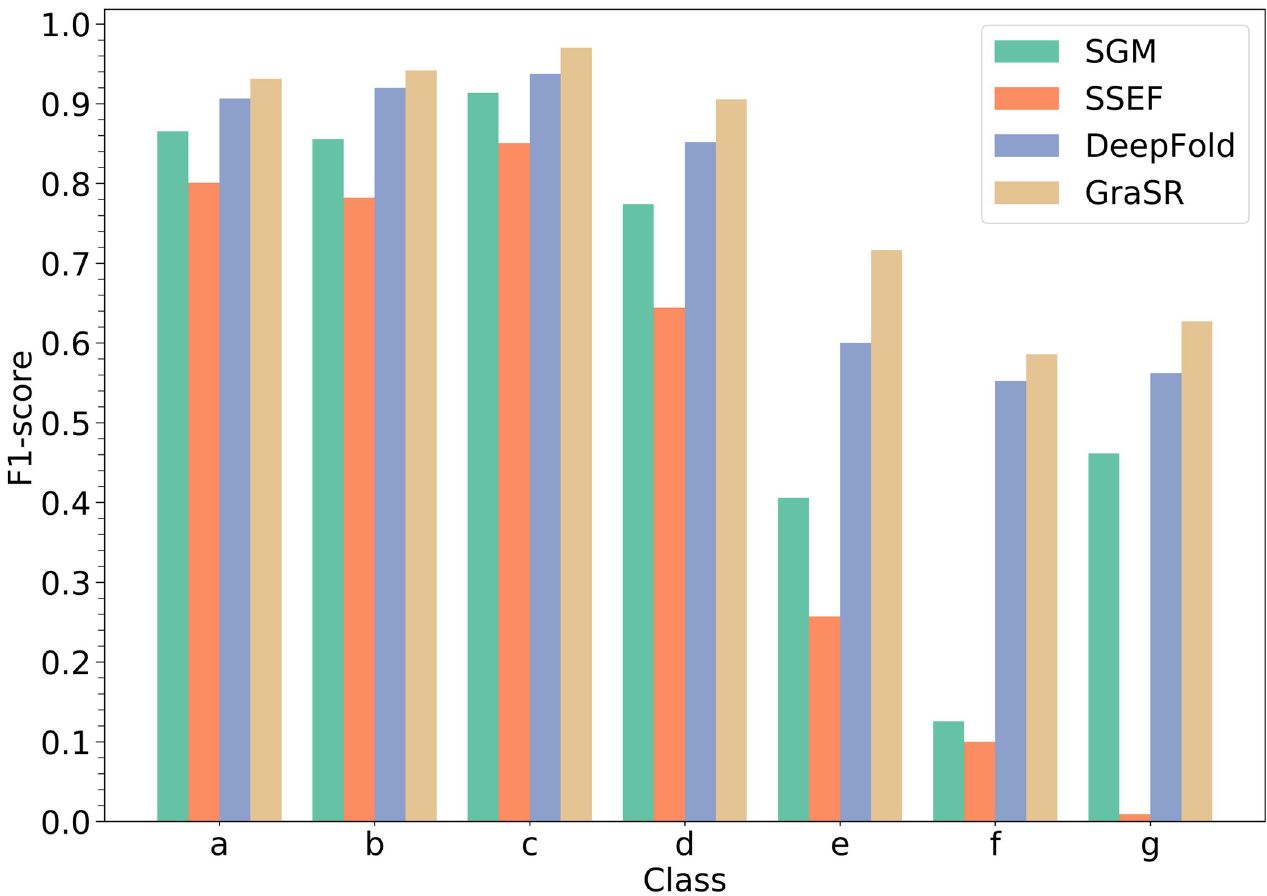
Fig 5. The F1-score of each class in SCOPe of GraSR and other baseline methods. a: All alpha proteins; b: All beta proteins; c: Alpha and beta proteins (a/b); d: Alpha and beta proteins (a+b); e: Multi-domain proteins (alpha and beta); f: Membrane and cell surface proteins and peptides; g: Small proteins.